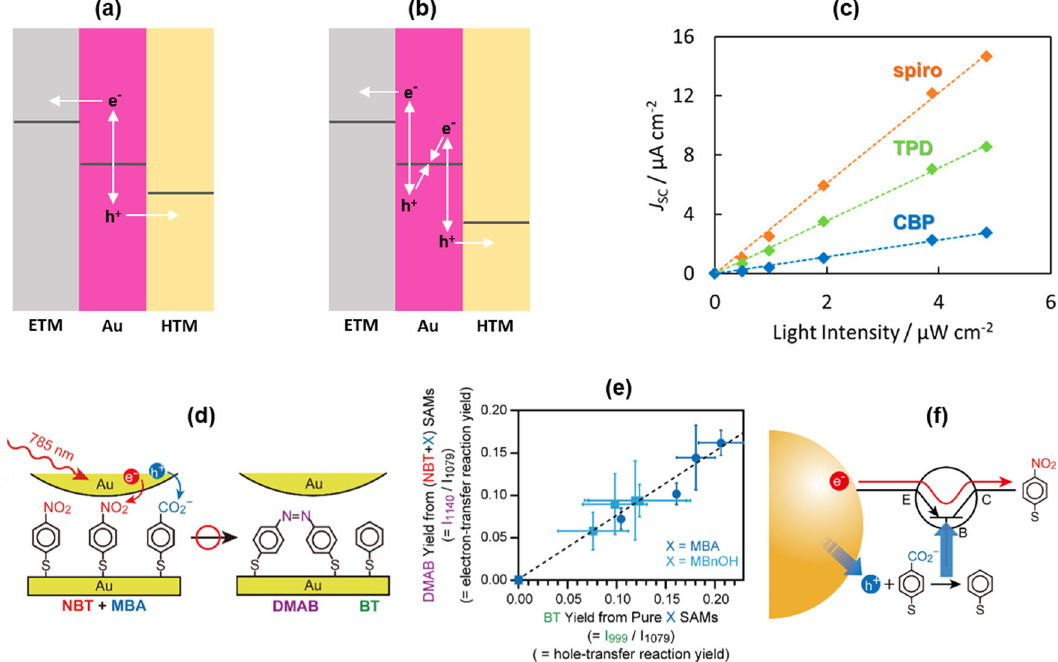
Fig. 5 Strategies for extraction of charge carriers. a Simultaneous and b stepwise injection of charge carriers to ETM and HTM. c Short-circuit photocurrent, J SC at 600 nm for the ETM – metal – HTM (E – M – H) cells with different HTMs and its dependence on the light intensity, for a fi xed intensity, the photocurrent decreases with increasing barrier height for hole transport ( a , b adapted with permission from ref. 46 Copyright © 2019, American Chemical Society and c reprinted with permission from ref. 46 Copyright © 2019, American Chemical Society). d The hole capture by MBA allows subsequent electron transfer to NBT, resulting in the formation of the DMAB product. e A linear relation between electron transfer and hole transfer reaction highlights the importance of hole extraction. f Schematic representation of a hole transfer channel, which regulates the fl ow of electrons by turning the transfer channel on or off. d , f Reprinted with permission from ref. 51 Copyright © 2020, American Chemical